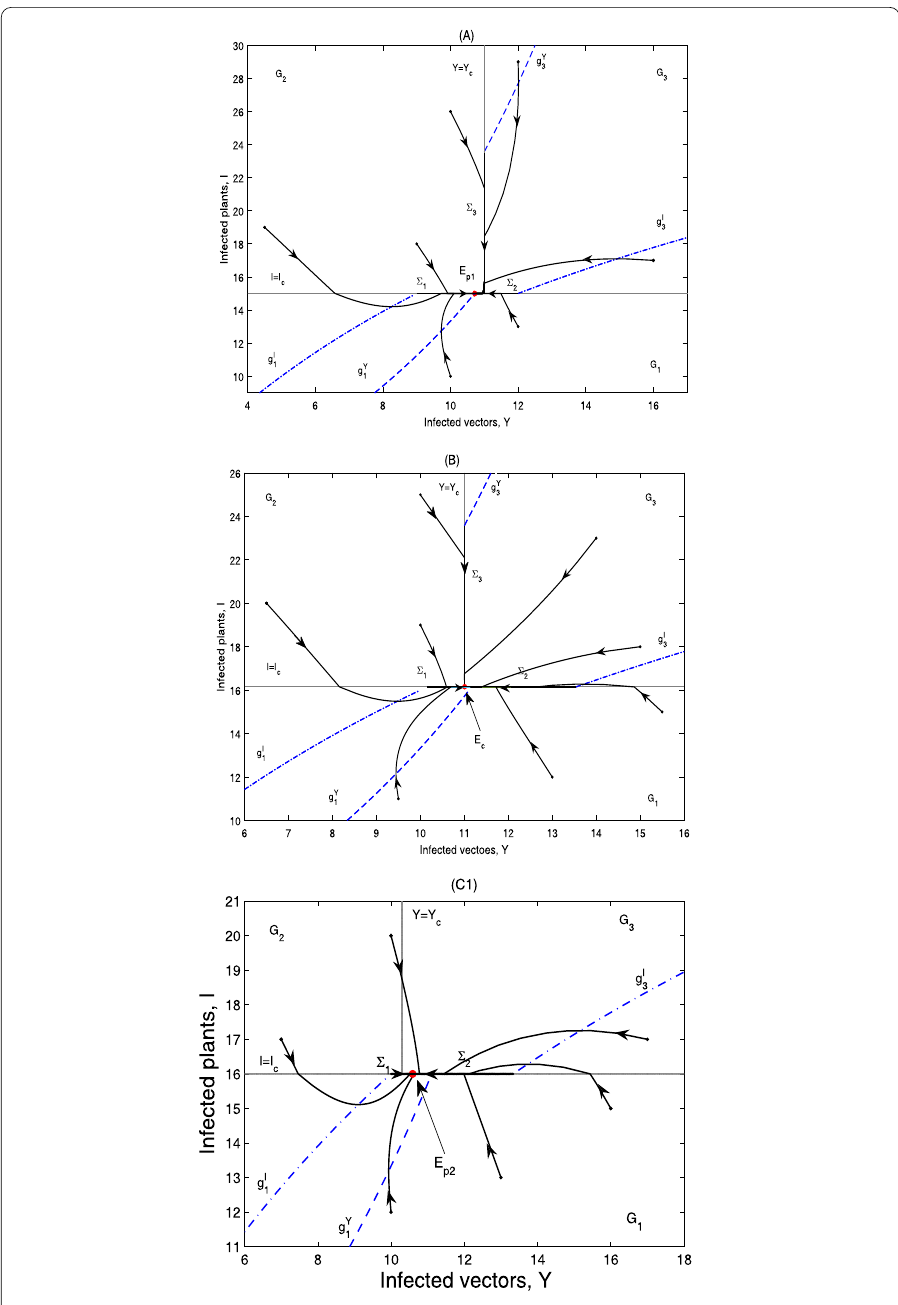
Figure 11 Global dynamics in Case C.2. ( A ) E p 1 is globally asymptotically stable. Y c = 11, I c = 15. ( B ) E c is globally asymptotically stable. Y c = 11, I c = 16.15. ( C1 ) E p 2 is globally asymptotically stable. Y c = 10.3, I c = 16. Σ 3 does not exist. ( C2 ) E p 2 is globally asymptotically stable. Y c = 10.7, I c = 16.5. Σ 3 = { ( Y , I ) ∈ Ω 2 : I c < I < g 2 } . (C2) is omitted